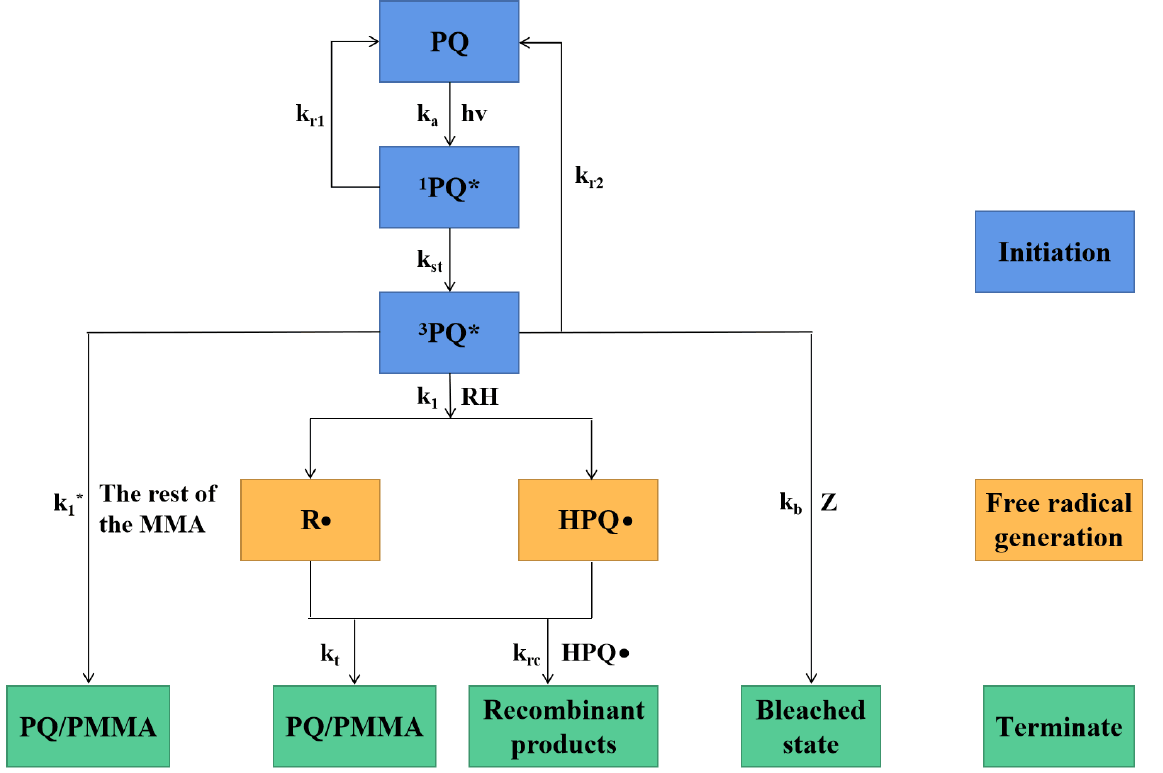
Figure 12. Photopolymerization reaction mechanism process, * represent the excited state of PQ.